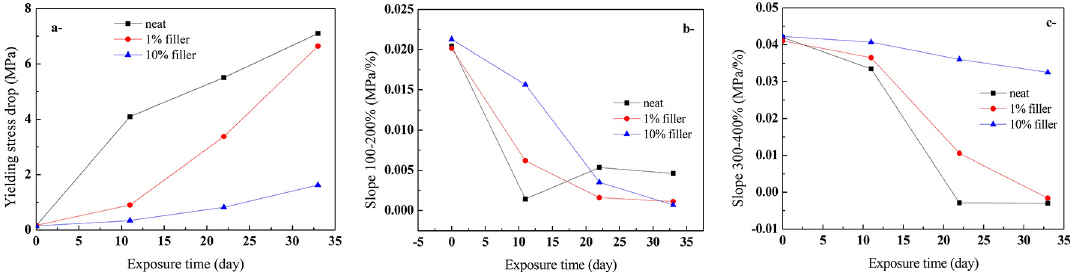
Figure 8. Data obtained from stress strain curves: (a) drop on stress after the yielding; (b) slope of curve between 100 and 200% of strain; and (c) slope between 300 and 400% of strain.